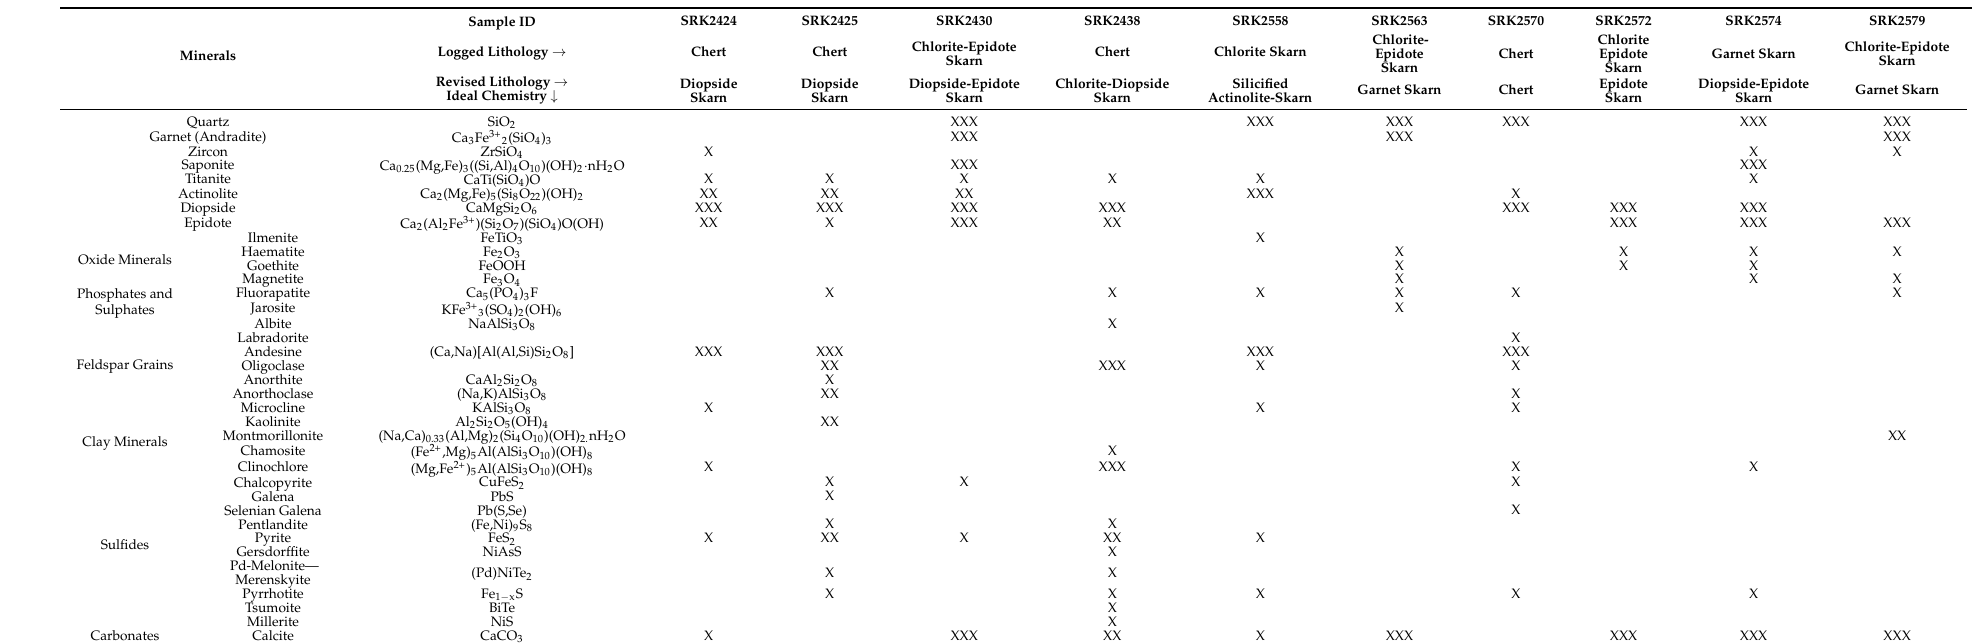
Table 4. Summary mineralogy of selected samples,